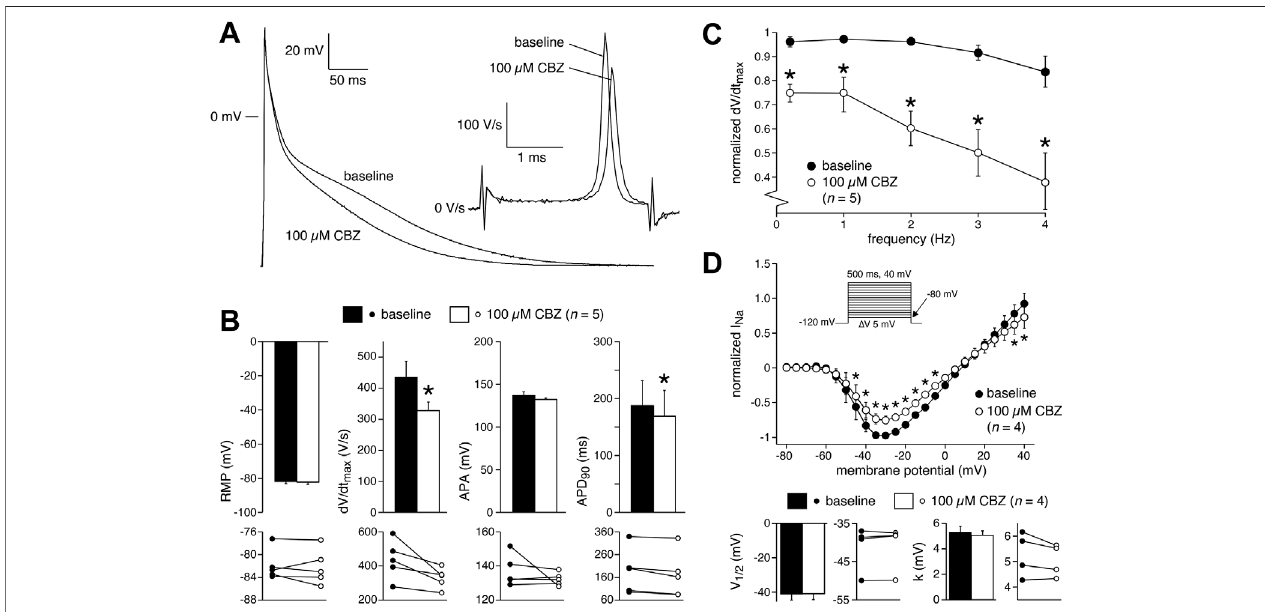
FIGURE 5 | Carbamazepine (CBZ) affects human atrial electrophysiology. (A) Superimposed representative human atrial APs at a stimulus frequency of 1 Hz in control conditions and in presence of100 µM CBZ. Inset: timederivatives during the AP upstroke phase. (B) Average AP characteristics at astimulus frequency of 1 Hz underbaselineconditions and in presence of100 µM CBZ (top panels) and individual (paired) datapoints (bottom panels). * p < 0.05 CBZ versusbaseline(One-Way RM ANOVA). (C) Average dV/dt max in response to 100 µM CBZ at stimulus frequencies ranging from 0.2 to 4 Hz. Values are normalized to the highest dV/dt max measured under baseline conditions. * p < 0.05 CBZ versus baseline (Two-Way RM ANOVA). (D) Average I-V relationship of I Na under baseline conditions and in presence of 100 µM CBZ (top panel) and V 1/2 and k of activation (bottom panels). Inset: voltage clamp protocol used. Cycle length was 5 s. I Na was normalized to the maximal peak amplitude underbaselineconditions, but peak current wasset to − 1 toretain thewell-known inward direction ofI Na .* p < 0.05 CBZ versus baseline (Two- Way RM ANOVA).